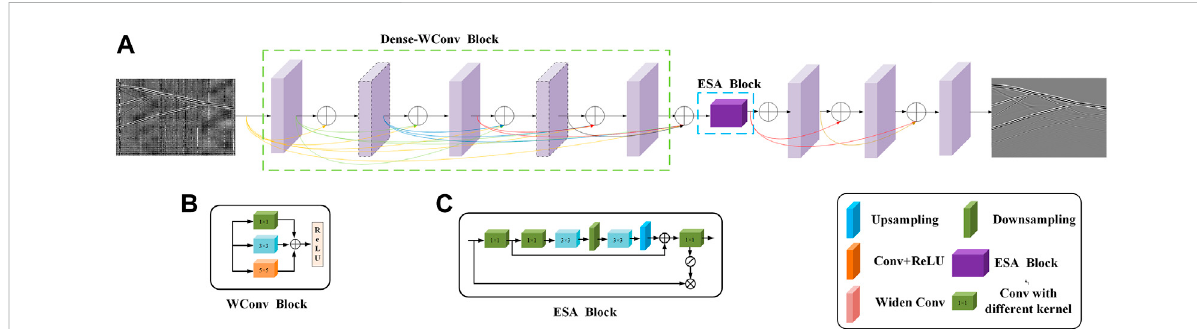
FIGURE 1 The Architecture for MDD-Net: (A) the architecture, (B) widen convolution block, and (C) ESA block.